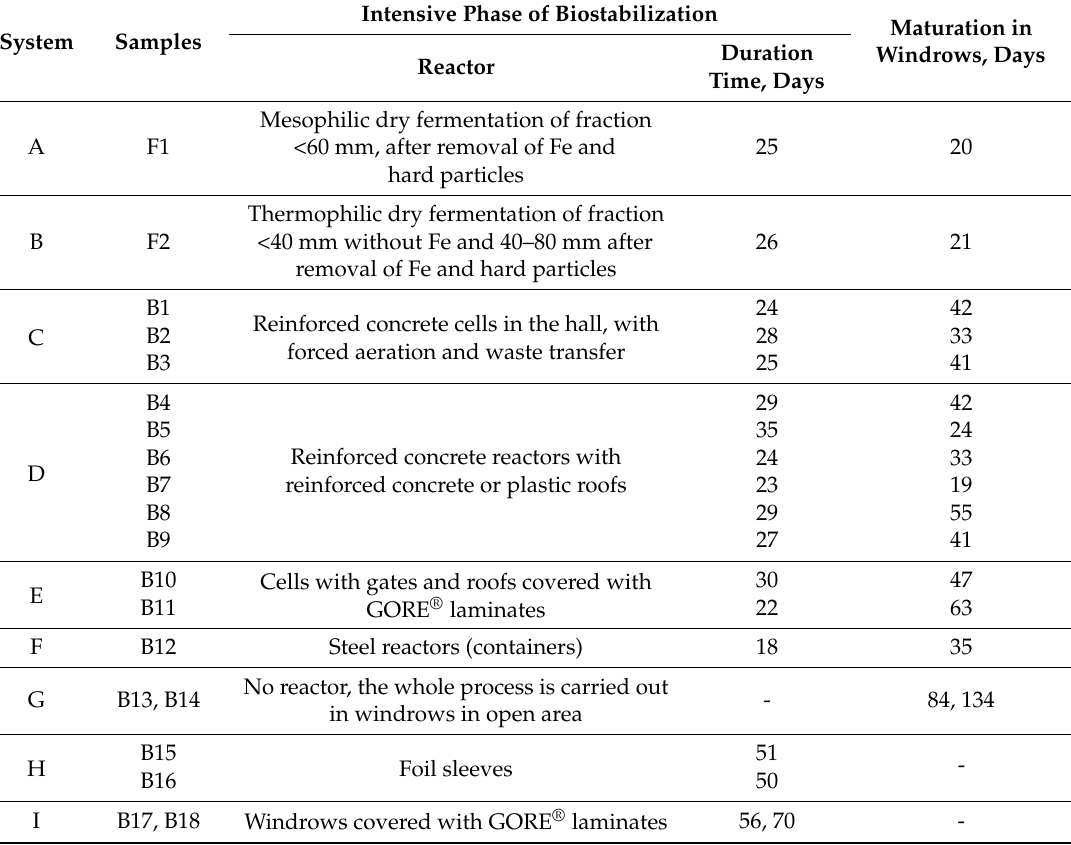
Table 1. The plans and waste samples examined in this